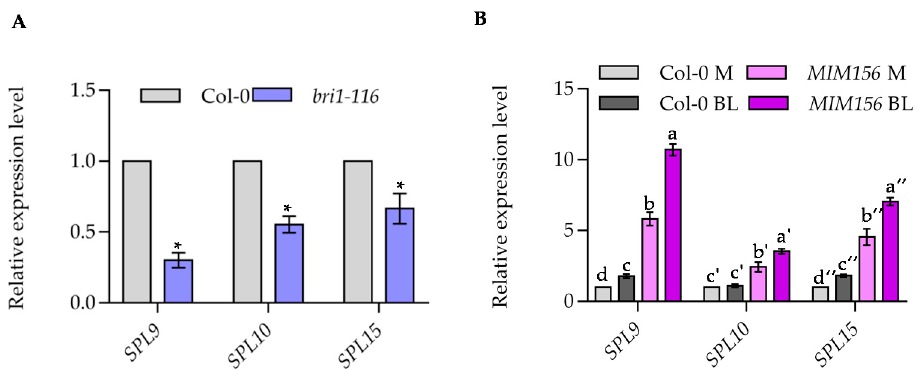
Figure 6. BR induces the expression of SPL9 , SPL10 and SPL15 . ( A ) Quantitative RT-PCR analysis the expression of SPL9 , SPL10 and SPL15 in wild type and bri1-116 mutants. Seedlings of Col-0 and bri1-116 were grown on ½ MS medium under constant light for 7 days. PP2A gene was analyzed as an internal control. Error bars represent standard deviation of three independent experiments. Asterisk between bars indicated statistically significant differences between the samples (Student t test, * p < 0.05). ( B ) BR increased the transcript of SPL9, SPL10 and SPL15 . Seedlings of wild type and MIM156 were grown on ½ MS medium for 7 days, and then treated with 100 nM BL for 3 h. PP2A gene was analyzed as an internal control. Error bars represent standard deviation of three independent experiments. Different letters above the bars indicated statistically significant differ- ences between the samples (ANOVA analysis followed by Uncorrected Fisher’s LSD multiple comparisons test, p < 0.05).